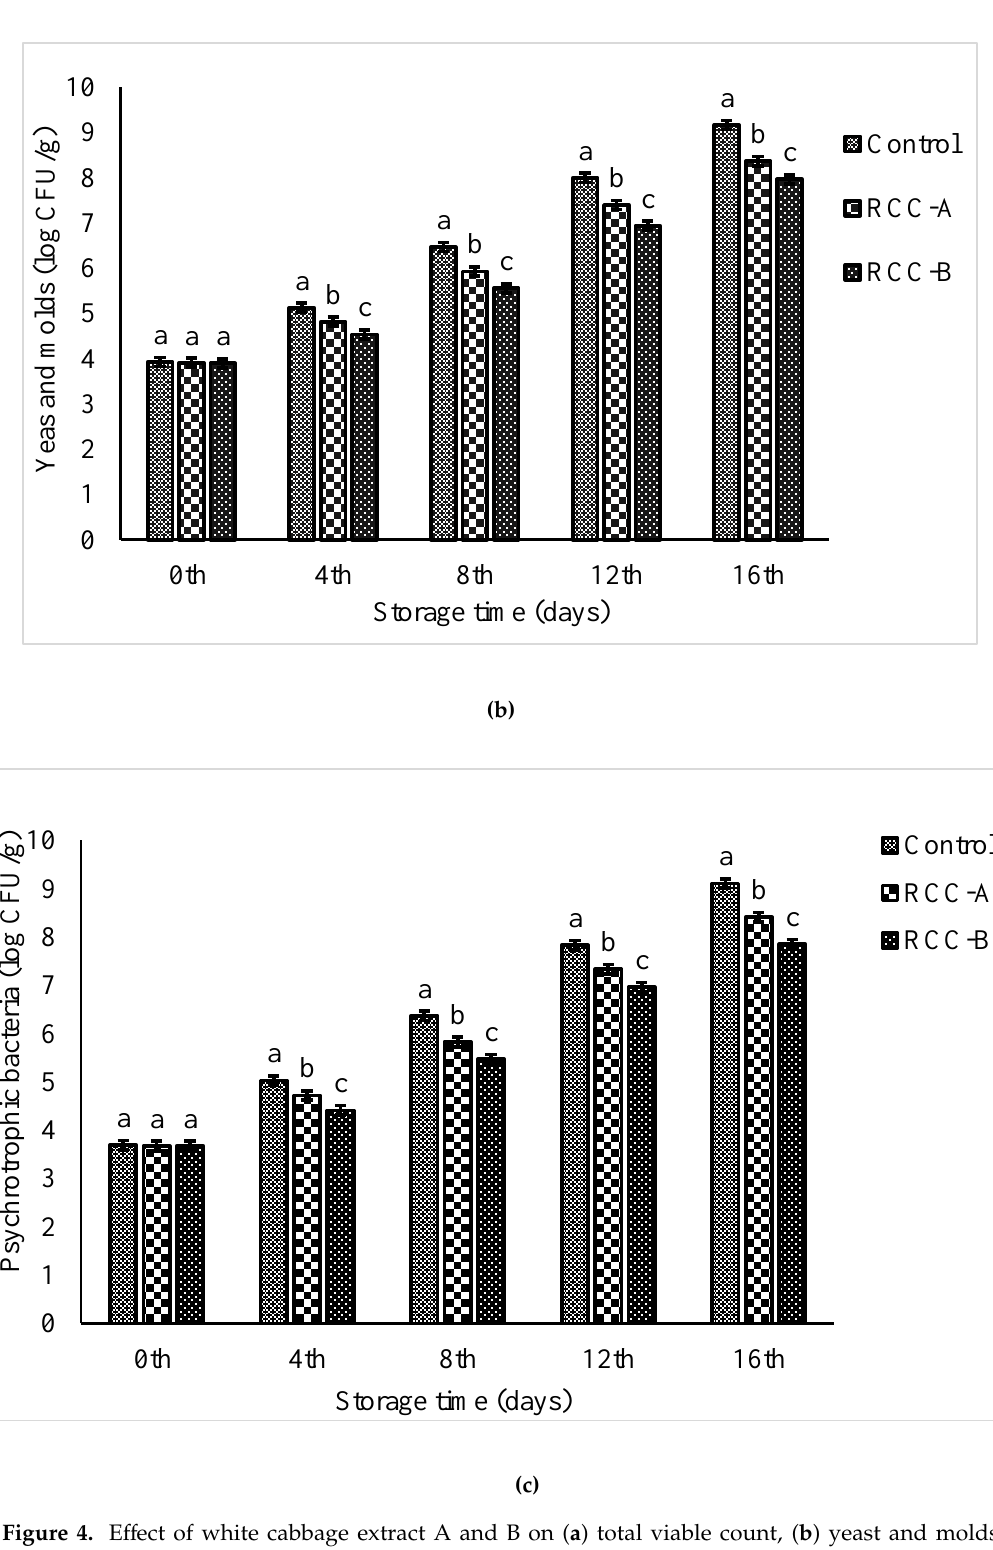
Figure 4. Effect of white cabbage extract A and B on ( a ) total viable count, ( b ) yeast and molds, and ( c ) psychrotrophic bacteria in beef meat during storage at 4 °C. Values representing mean ± SD of three replicates; different letters indicate significant difference ( p < 0.05) for each time; same letters indicate no significant difference ( p > 0.05) for each time.